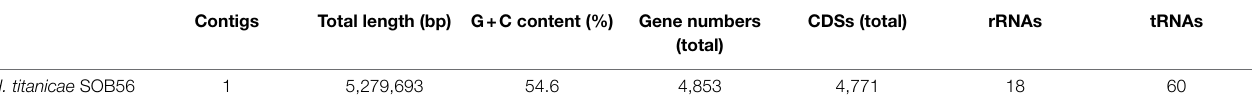
TABLE 1 | Genome features of Halomonas titanicae SOB56.